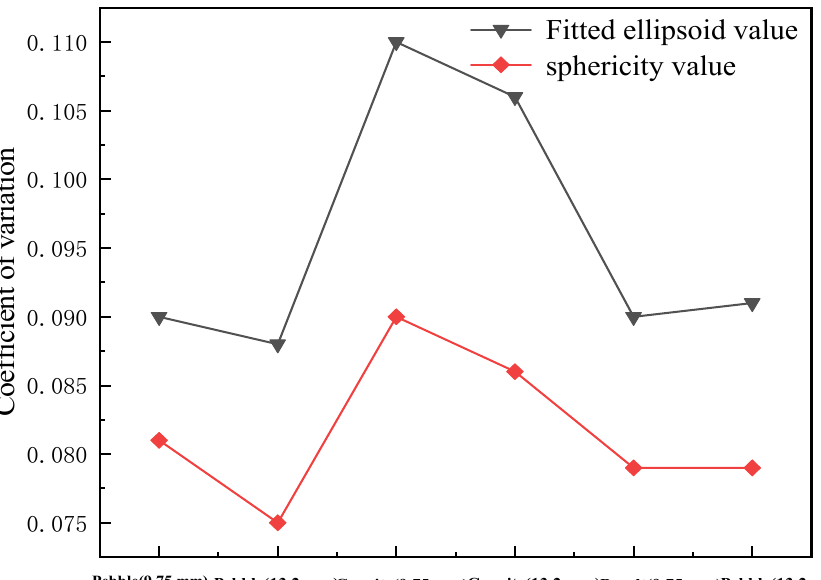
Figure 15. Comparison of coe ffi cient of